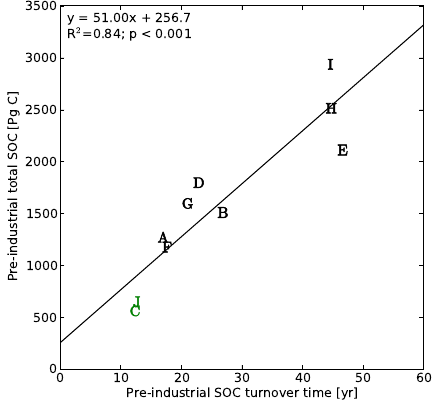
Figure 3. Relationship between pre-industrial SOC input and pre- industrial total SOC stocks at the beginning of the historical experi- ment. Letters correspond to the same models as in Table 1 and mod- els in green (i.e. C and J) integrate nitrogen limitation. The solid line is a linear relationship constructed using all models with equation, R 2 and p values indicated in the top left corner.